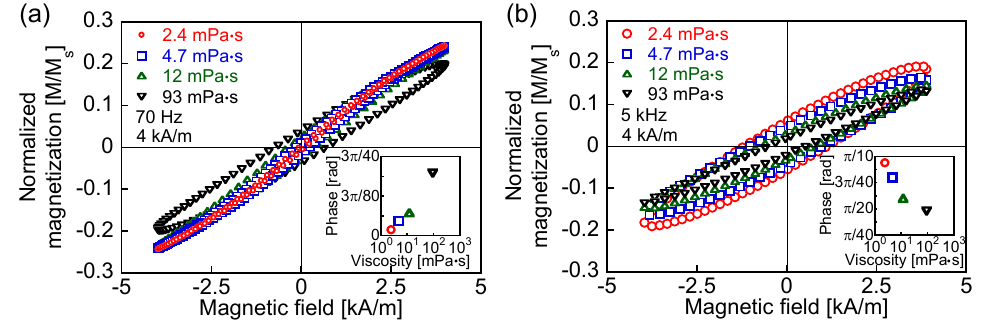
Figure 5. Measured AC hysteresis loops for viscosities of 2.4, 4.7, 12, and 93 mPa ∙ s at frequencies close to the ILP peak for viscosities of ( a ) 93 and ( b ) 2.4 mPa ∙ s at ( a ) 70 Hz and ( b ) 5 kHz, respectively. The insets show the dependence of the phase delay on the viscosity, which was derived from the coercivities of the AC hysteresis loops.